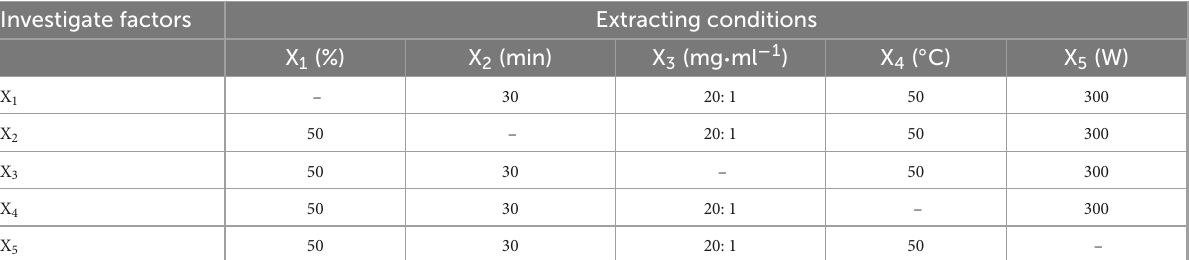
TABLE 2 Extraction conditions of single-factor